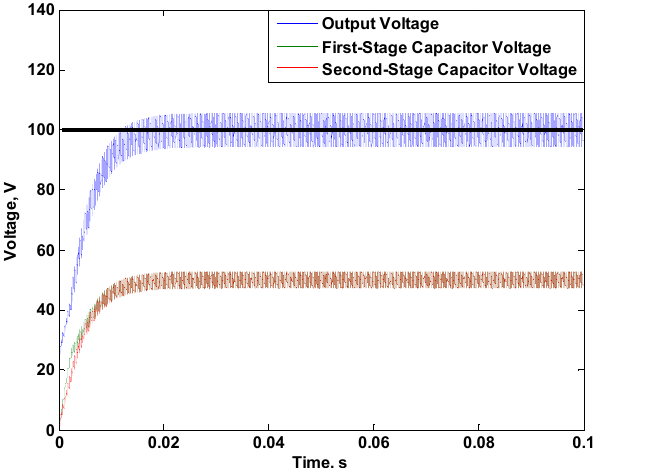
Figure 14. Adopted closed-loop control technique.